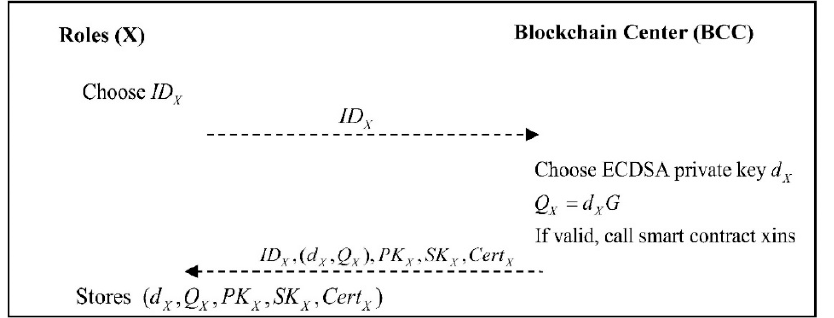
Figure 4. Each role of the system registers with the Blockchain Center.